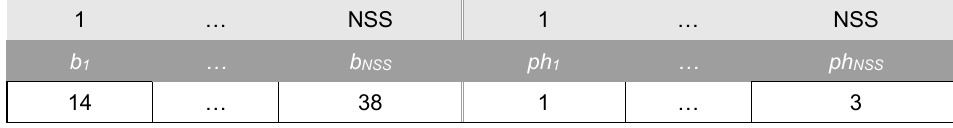
Figure 2. A chromosome for the ESMRG algorithm.